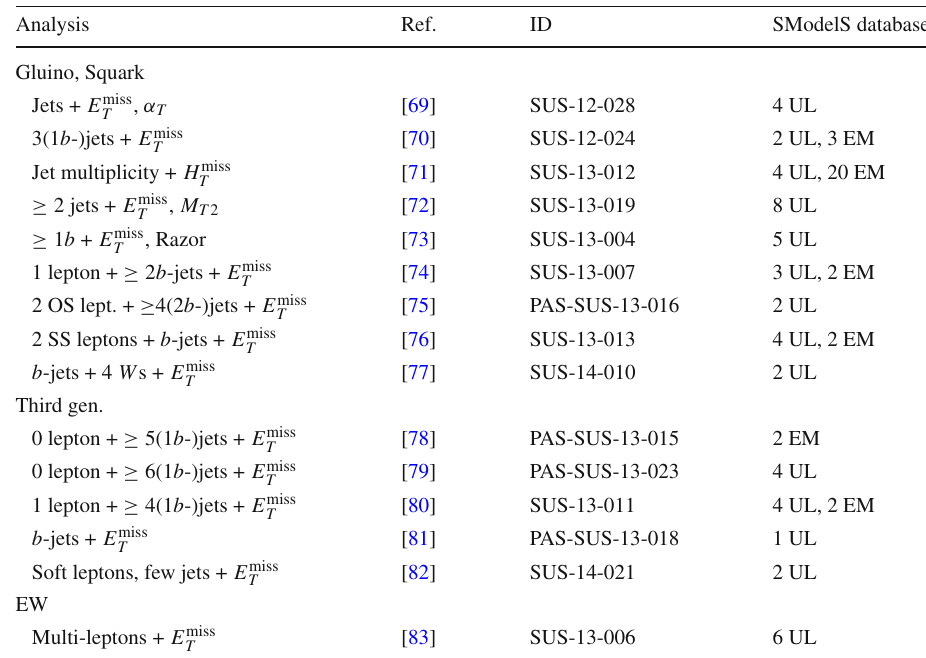
Table 3 CMS 8 TeV results included in the SModelS v1.1.1